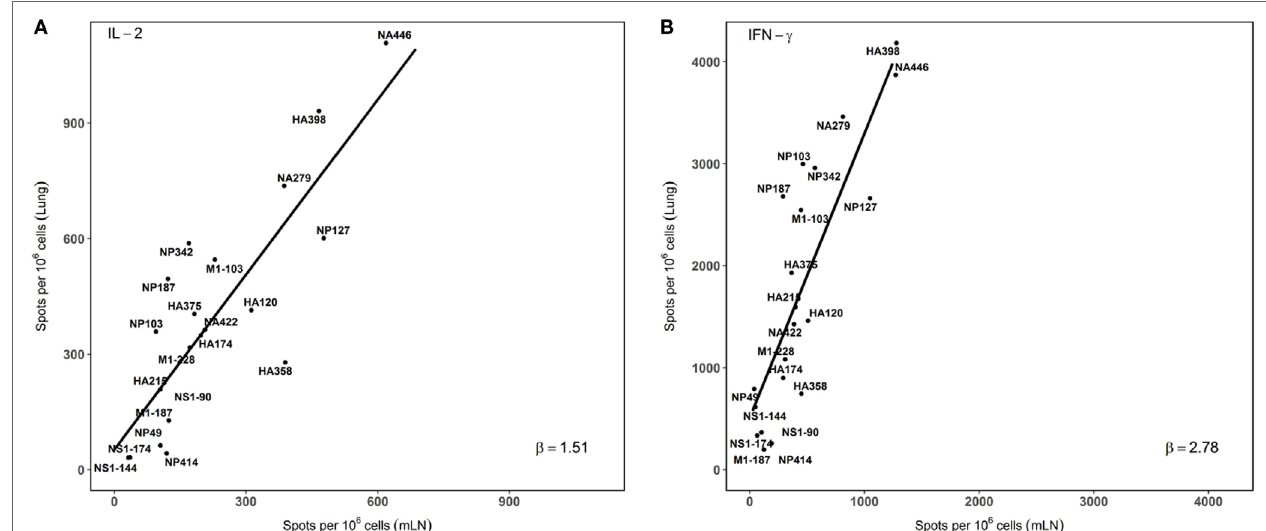
FigUre 4 | Immunodominance hierarchy of epitope specific CD4 T cells isolated from draining lymph node (dLN) is preserved in the lung lung. IL-2 and IFN- γ Elispots were performed as described from cells isolated at day 10–11 postinfection. Individual values for IL-2 (a) or IFN- γ (b) EliSpots from three independent experiments from Figure 2 , with the SD values indicated in Figure 2 . The average values were tabulated and analyzed using linear regression models, using each data point. The slopes of the derived line (“ β ”) were calculated and are indicated in each panel. Shown are the average values of spots per million CD4 T cells for each epitope data set tested. (a) beta (slope) = 1.51. r 2 = 0.63. p value < 0.001. (b) : beta (slope) = 2.78, r 2 = 0.64. p value <